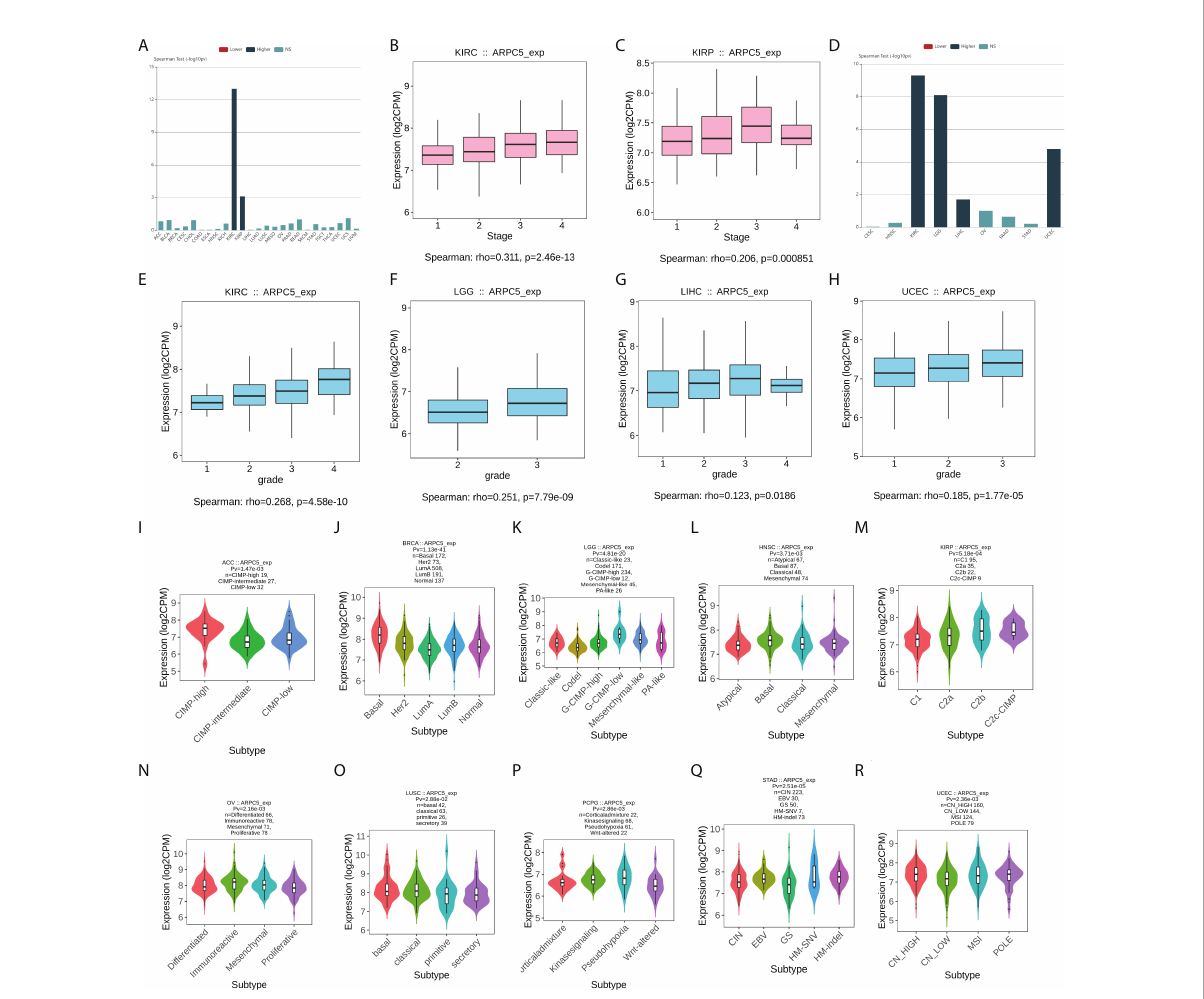
FIGURE 5 The correlation between ARPC5 expression and clinical stage, histologic grade, and tumor molecular subtypes in various cancers based on Spearman ’ s correlation analysis (the correlation with p < 0.05 were displayed). (A) The correlation between ARPC5 expression and clinical stage in pan-cancer. (B – C) The expression levels of ARPC5 in different clinical stages of KIRC (B) and KIRP (C) . (D) The correlation between ARPC2 expression and histologic grade in pan-cancer. (E – H) The expression levels of ARPC5 in different histologic grades of KIRC (E) , LGG (F) , LIHC (G) , and UCEC (H) . (I – R) The correlation between ARPC5 expression and molecular subtypes in ACC (I) , BRCA (J) , LGG (K) , HNSC (L) , KIRP (M) , OV (N) , LUSC (O) , PCPG (P) , STAD (Q) , UCEC (R) . rho; rank coef fi cient of Spearman. Pv; p -value. NS, no signi fi